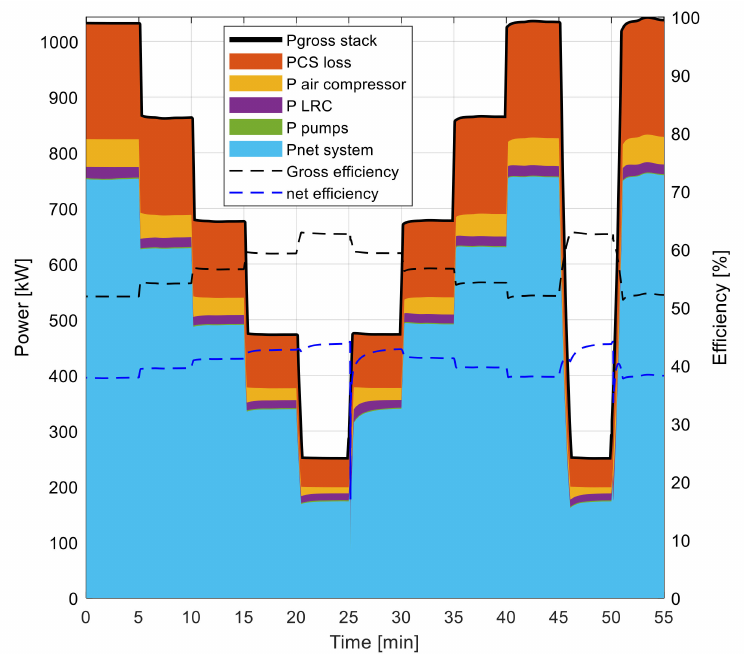
Figure 6. Simulation of load-following operation: time profile of gross power generations, power internal consumptions and net power generation (left axis) and gross stack and net system efficiency (right